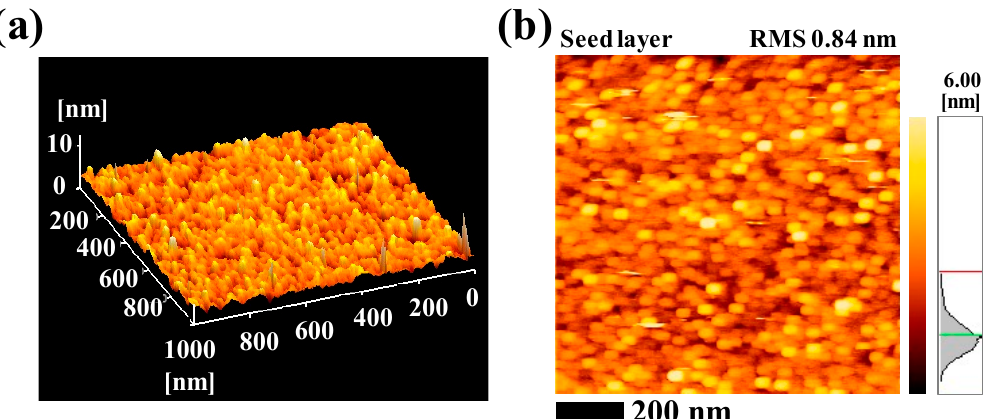
Figure 2. ( a ) 3D atomic force microscopy (AFM) image of ZnO-coated SiO 2 /Si substrate deposited using the spin coating technique, and ( b ) the surface roughness.